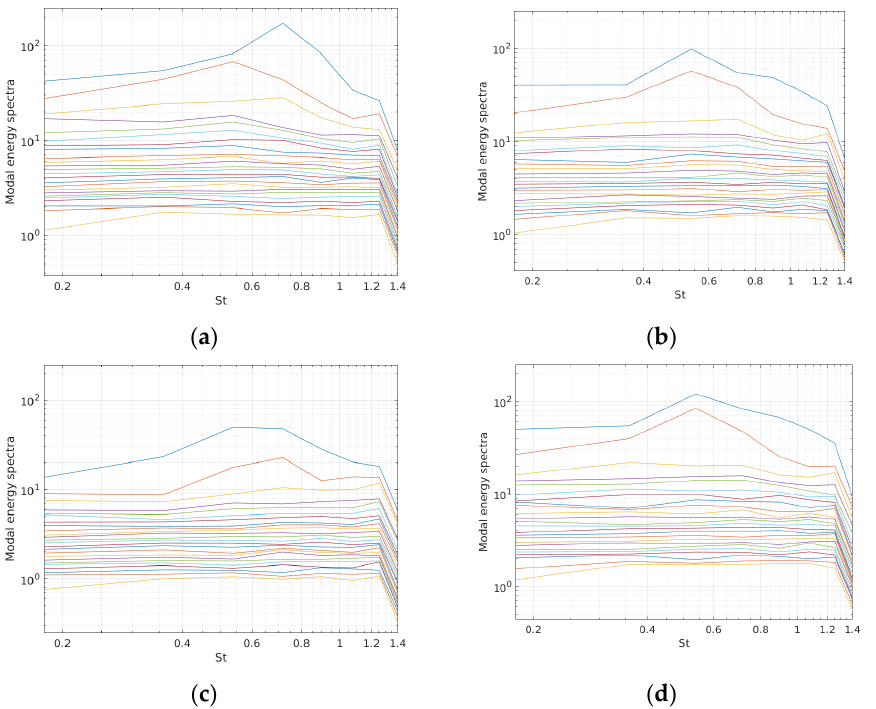
Figure 22. Modal energy spectra for case ‘0-0’ of x -component ( a ) and y -component ( c ) of velocity and for case ‘0-60’ x -component ( b ) and y -component ( d ) of velocity on XY symmetry plane. The different colour lines represent the different modes.